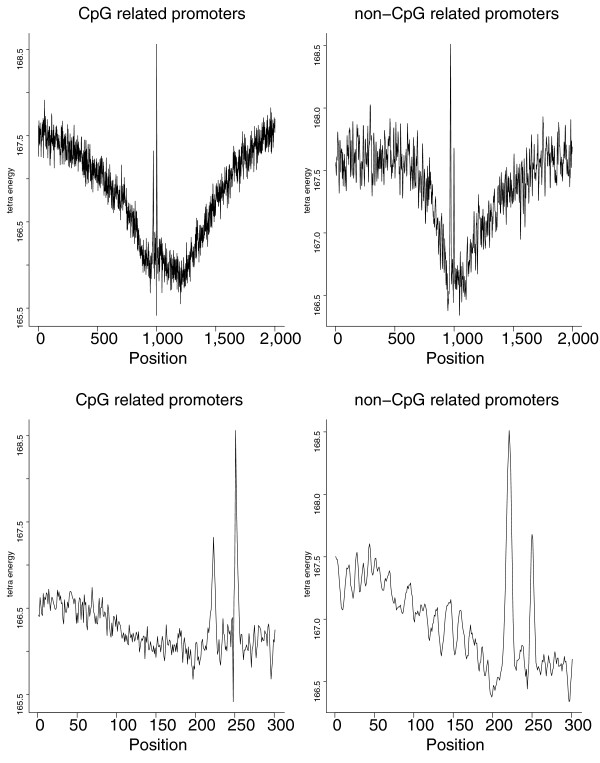
The energy profiles of CpG-related promoters and non-CpG-related promoters. The transcription start site is located at position 1000 in the top figures and position 250 in the bottom figures. All of the plots were smoothed with an average window of width 5. TSS, transcription start site.